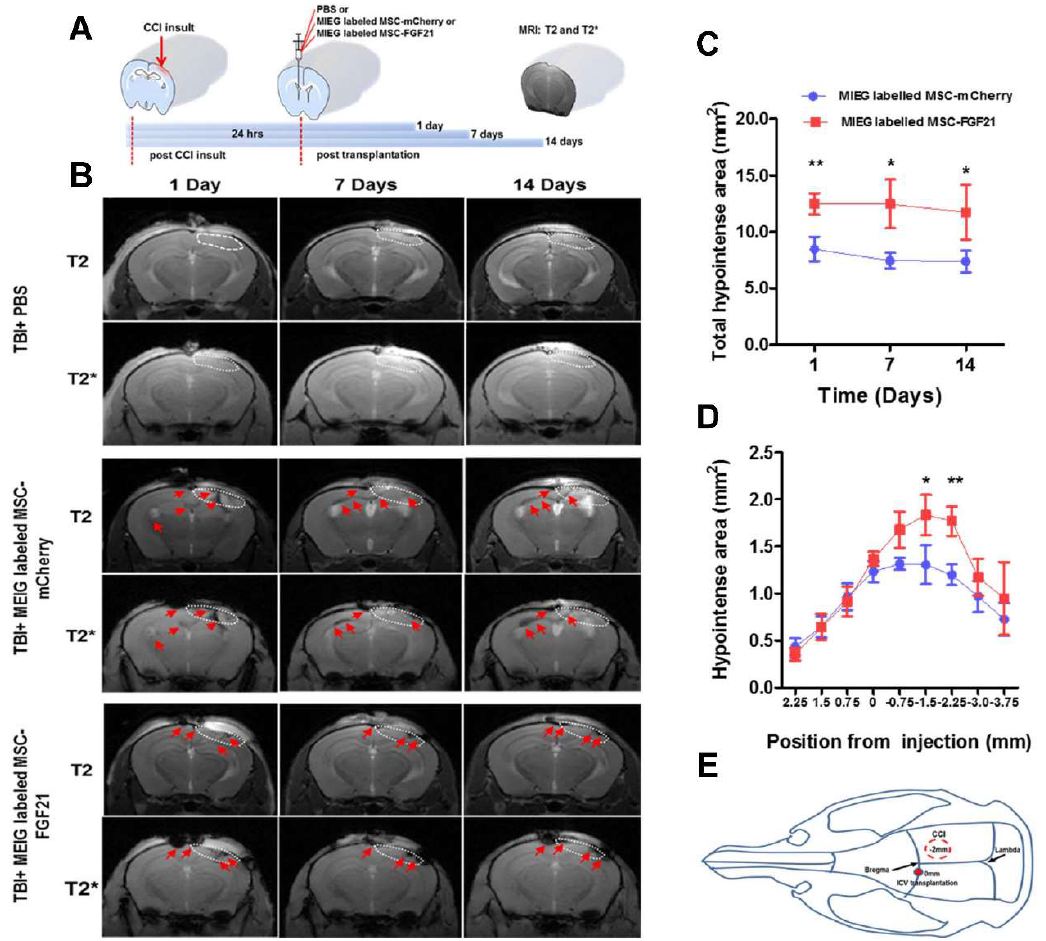
Figure 6. Detecting and tracking the homing of MIEG-labeled MSC in vivo. ( A ) Graphic and schematic illustration timeline of real-time T2* and T2WI MRI scanning of mice brains following controlled cortical impact (CCI) injury and MIEG-labeled MSCs transplantation. ( B ) Representative images of T2* and T2WI MRI scanning at different time point showing the homing of transplanted MIEG- labeled MSC-FGF21 and MSC-mCherry as hypointense signals (red arrows) at the injury site (dotted lined area). Time course evaluation of total hypointense areas generated by MIEG-labeled MSC- FGF21 and MSC-mCherry. ( C ) Time course evolution of total hypointense area showed no significant differences between 1, 7 and 14 days, but showed differences between the two groups. ( D ) Distributions of hypointense areas generated by MIEG-labeled MSC-FGF21 and MSC-mCherry 14 days post-transplantation in mice brains expressed as distances anterior (positive) and posterior (negative) to the transplantation site. ( E ) Graphic illustration of CCI injury site and MSC transplantation coordinate used in the current study. Quantified data are mean ± SEM ( n =7 – 8 animals per group). * p <0.05, ** p <0.01 compared between MIEG labeled MSC-FGF21 and MIEG labeled MSC- mCherry treated TBI animals.